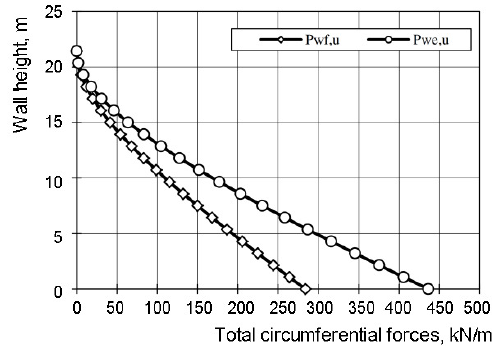
Fig. 3. Diagrams of total circumferential forces (for filling and discharging) in the silo